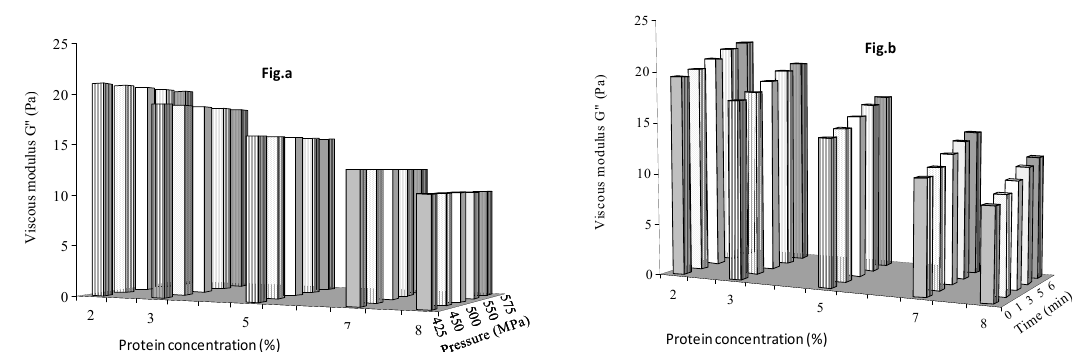
Figure 6. Viscous modulus as influenced by protein concentration and ( a ) pressure ( b ) holding time.